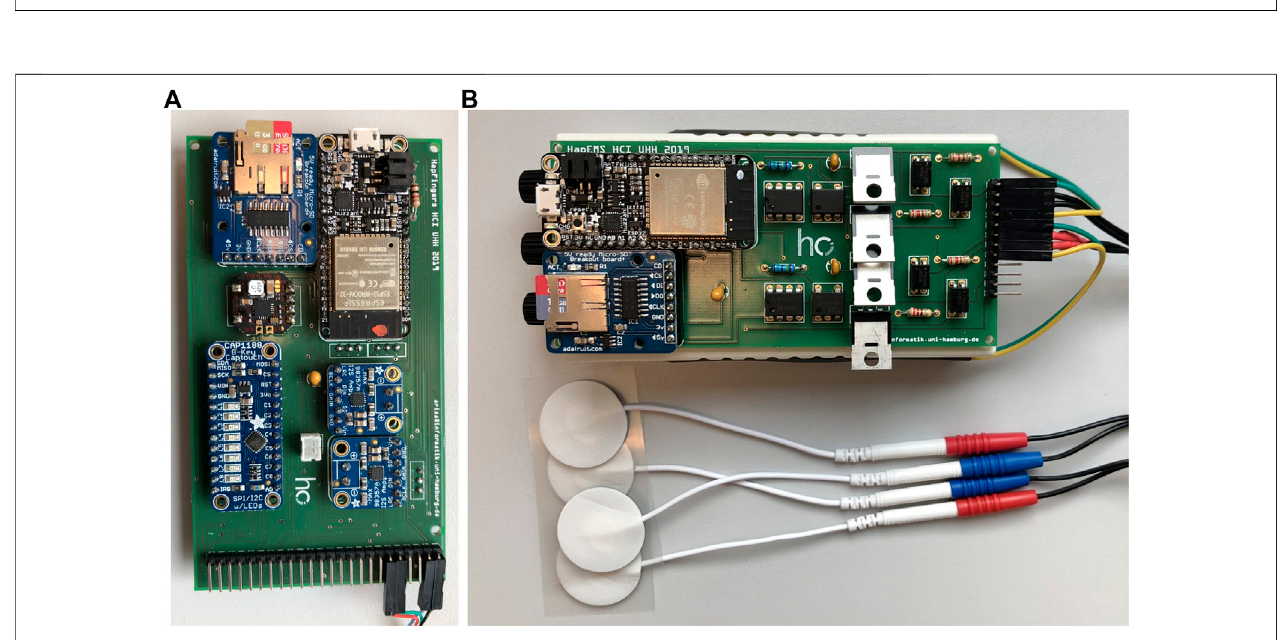
FIGURE 2 | Detailed picture of the wearable modules. (A) The tactile module, used to provide tapping and vibrotactile feedback using solenoids and piezo elements respectively. (B) Theelectricalstimulationmodule,usedtoprovideproprioceptivecuestoinducetheillusionof fi ngerextensionbyusingelectrodesinthedorsalpartofthehand.